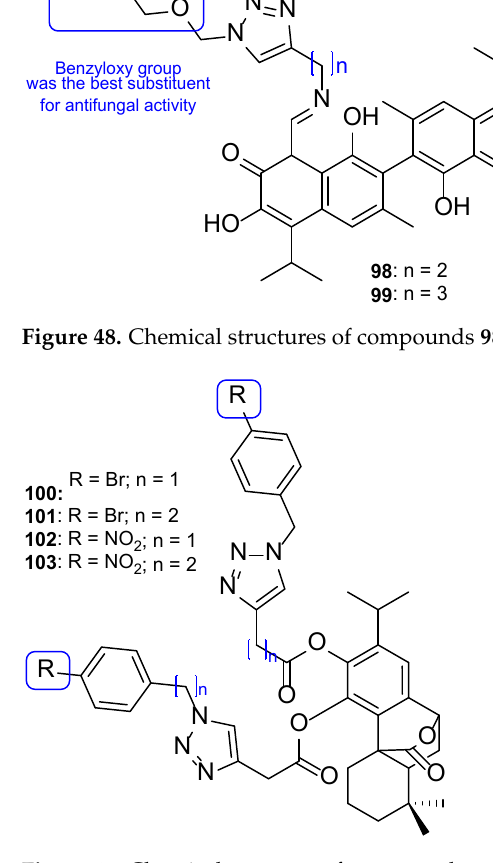
Figure 49. Chemical structure of compounds 100 – 103 [134].